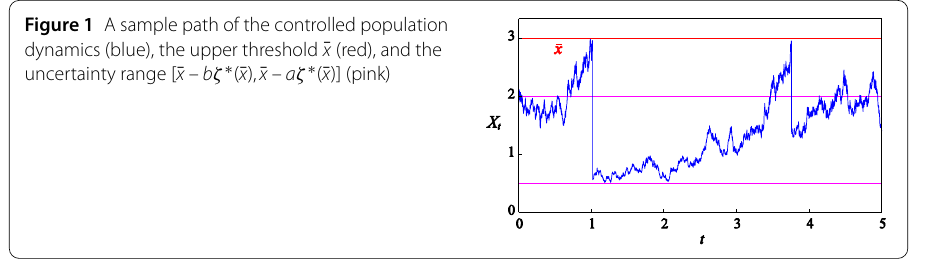
Figure 1 A sample path of the controlled population dynamics (blue), the upper threshold ¯ x (red), and